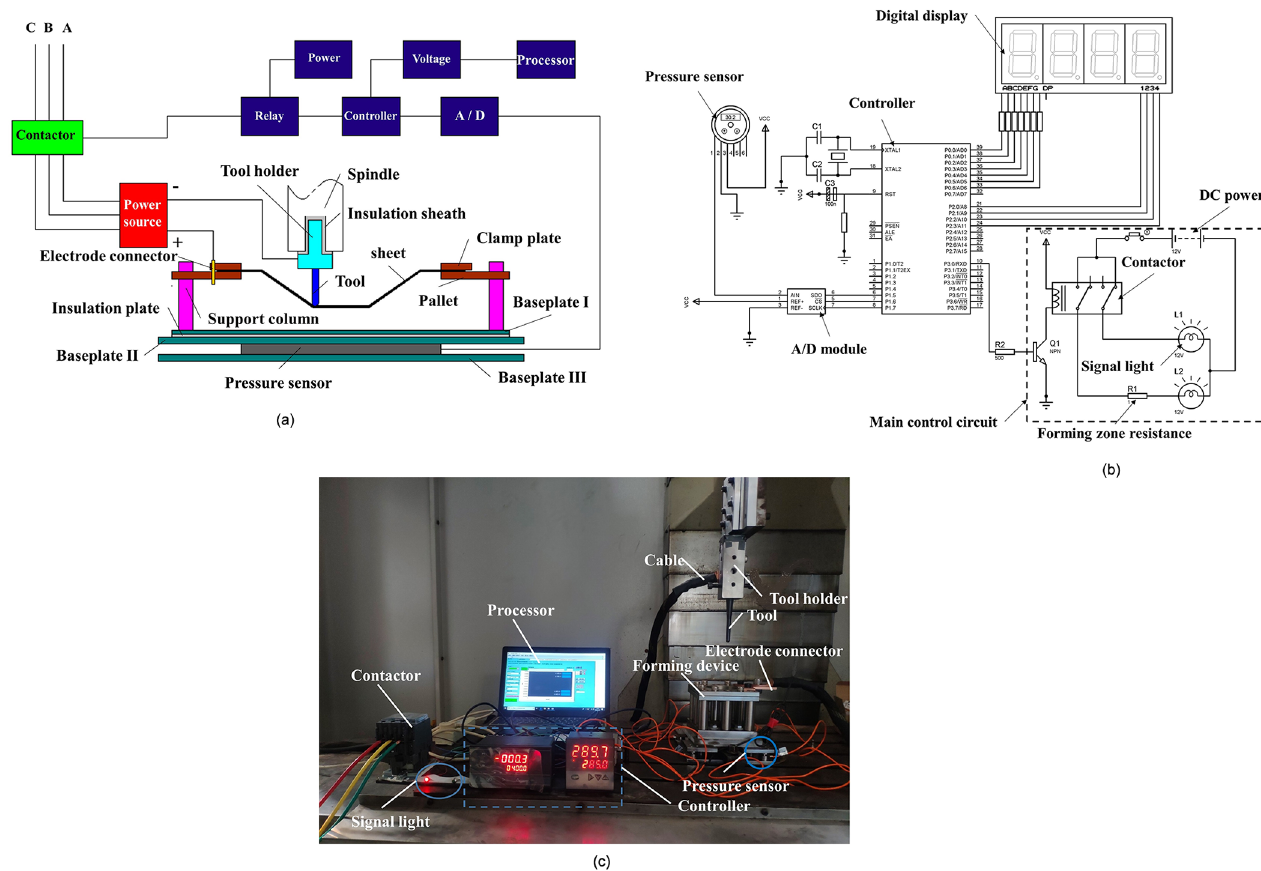
Fig. 3. Principle and test platform of pressure response control: (a) Control scheme, (b) control circuit, and (c) test platform.